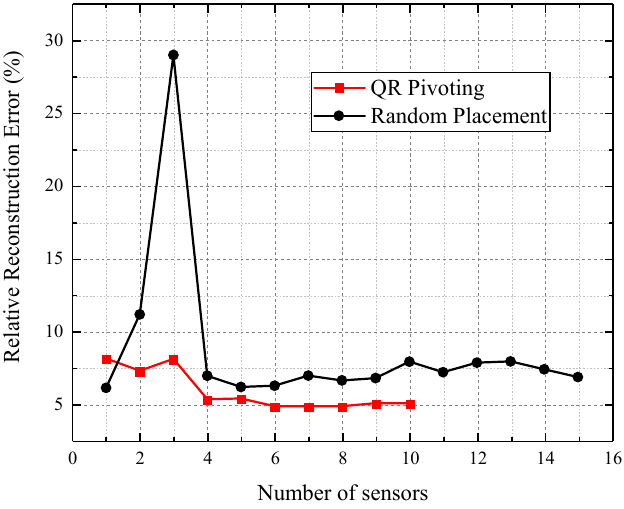
Figure 29. Reconstruction errors with a different number of sensors. Table 9. Measured value (m/s), CFD value (m/s), reconstructed value (m/s) and error (%) of each